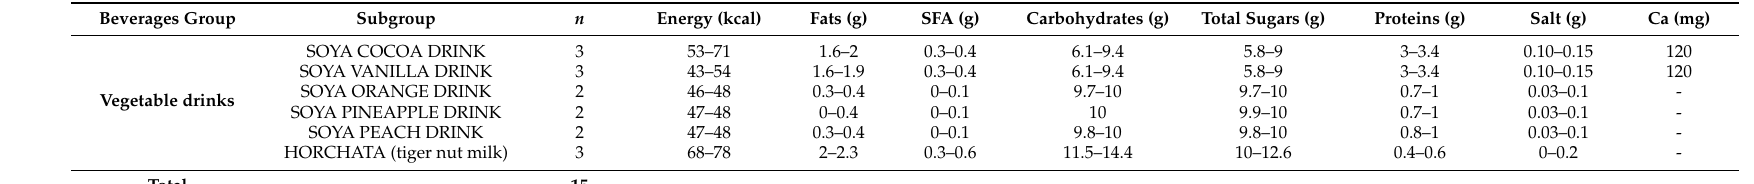
Table 6. Nutrition facts from the “vegetable drinks” group in the Spanish food